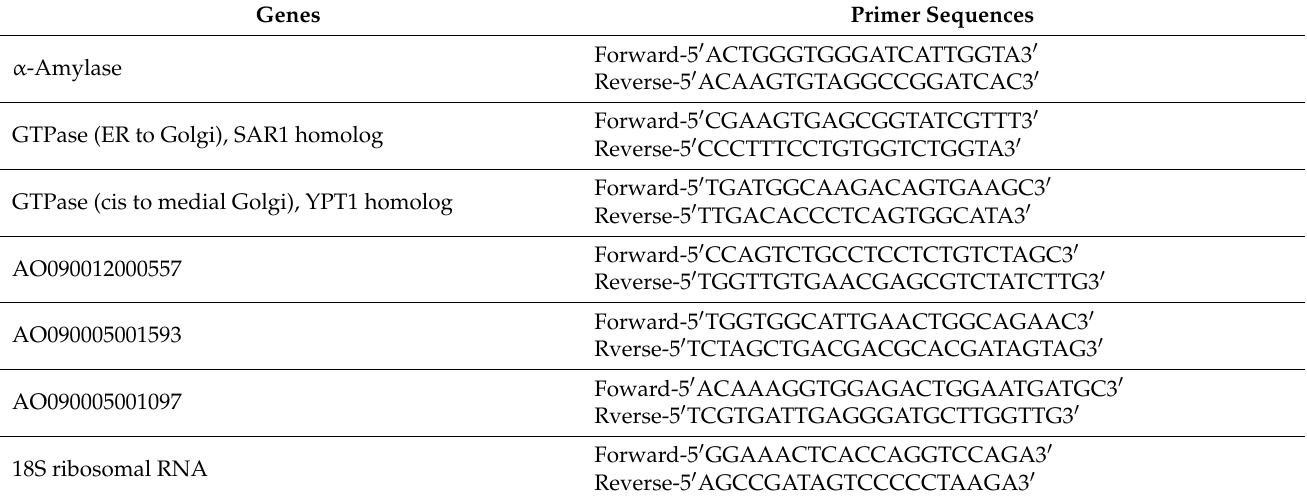
Table 2. List of primers used in qPCR. Genes Primer Sequences Forward-5 (cid:48) ACTGGGTGGGATCATTGGTA3